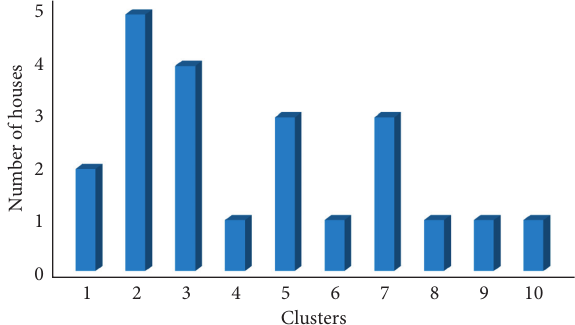
Figure 10: Cluster